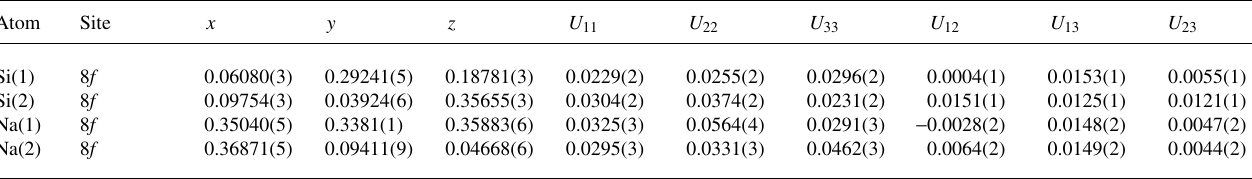
Table 2. Atomic coordinates and displacement parameters (in Å 2 )